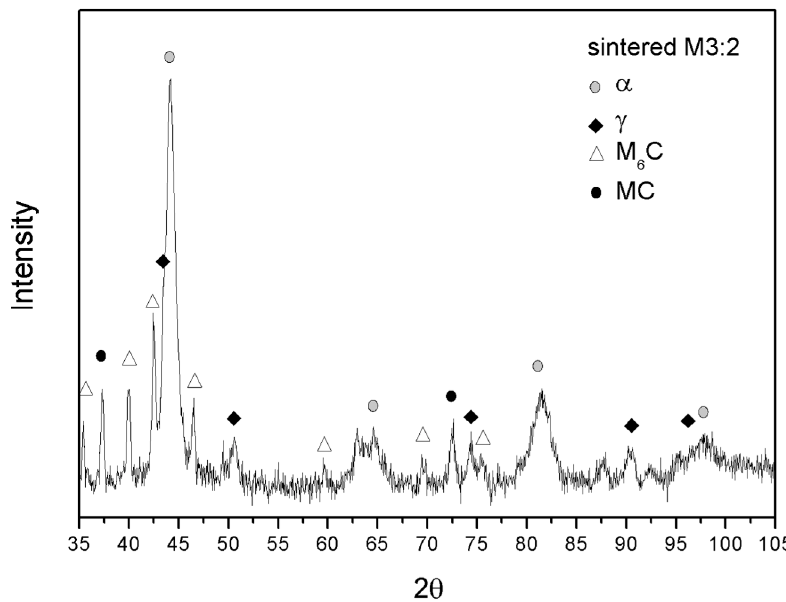
Figure 9. X-ray diffraction pattern for sintered M3:2.